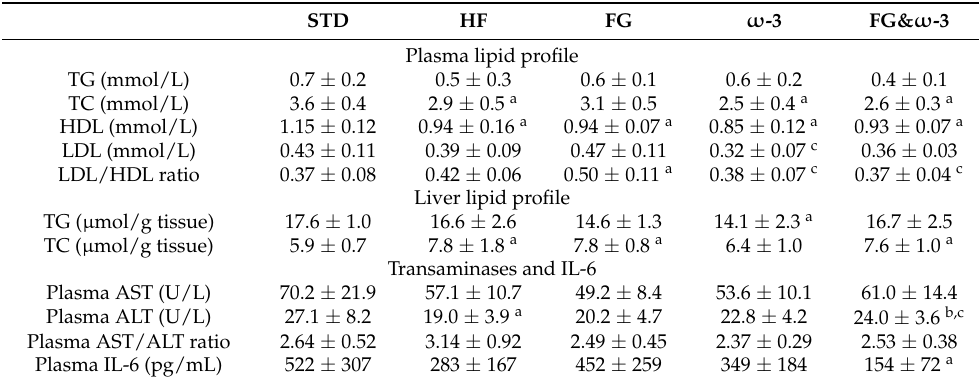
Table 1. Lipid profile, transaminases and interleukin-6 after 21 weeks of dietary intervention.